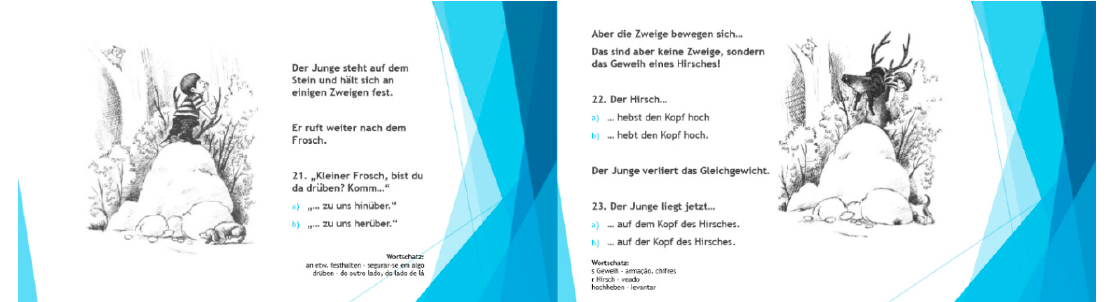
Figure A35. Posttest: Binary-choice recognition task.